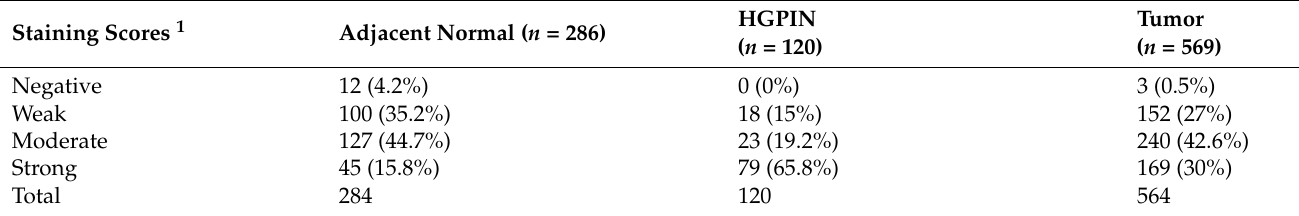
Table 2. GLO1 immunodetection during tumorigenic progression in arrayed prostate patient